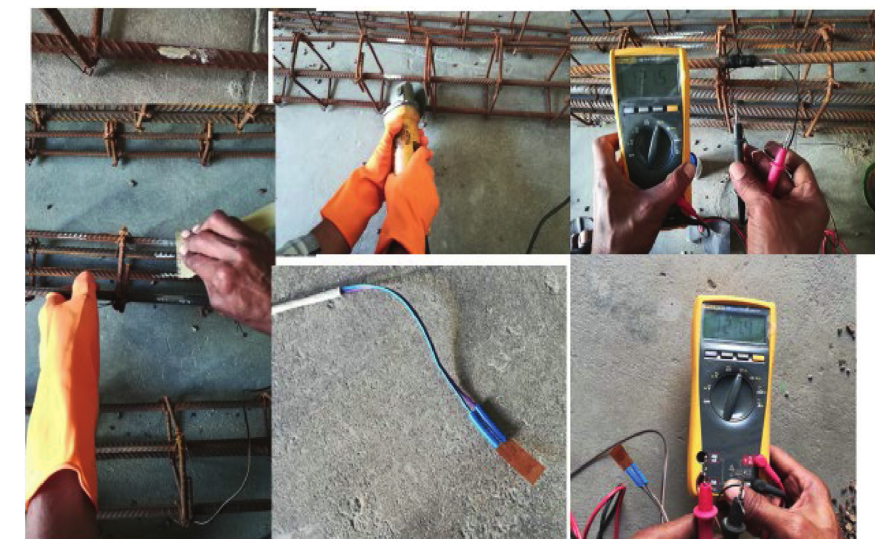
Figure 5: Procedure to fix strain